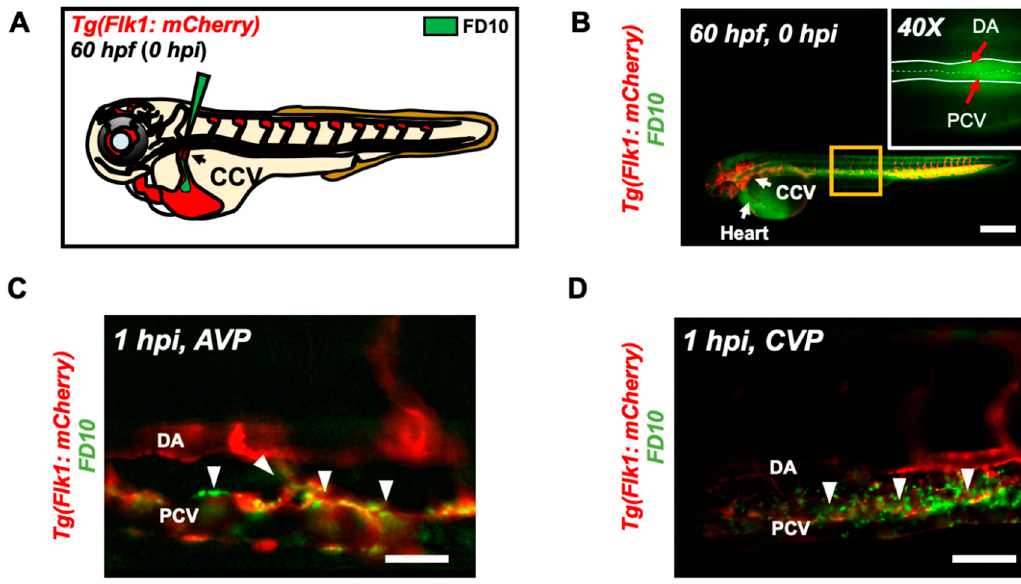
Figure 3. Micro-angiography via common cardinal vein (CCV) to mimic UFP gavage. ( A ) A schematic representation of micro-angiography via CCV to introduce FD10 to the microcirculatory system. ( B ) A representative image of the transgenic Tg(flk1: mCherry) embryo following FD10 injection to CCV. At 0 hpi, FD10 fluorescence was prominent at the injection site, CCV, heart, DA and PCV. Scale bar: 100 µm. ( C – D ) At 1 hpi, FD10 was distributed in the AVP and CVP, between the DA and PCV, mimicking UFP gavage-mediated effects (white arrowheads, n = 5 per group). Scale bar: 32 µm.